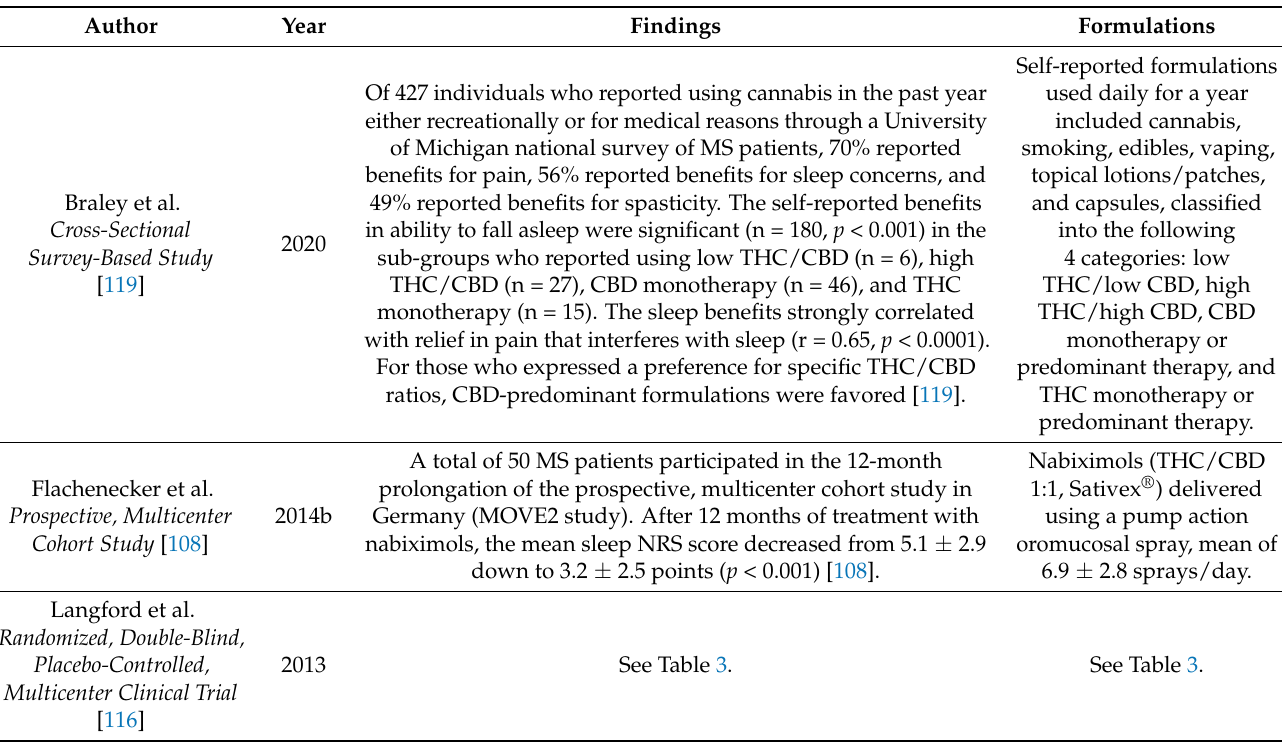
Table 4. Effects of cannabinoids on sleep disturbance in multiple